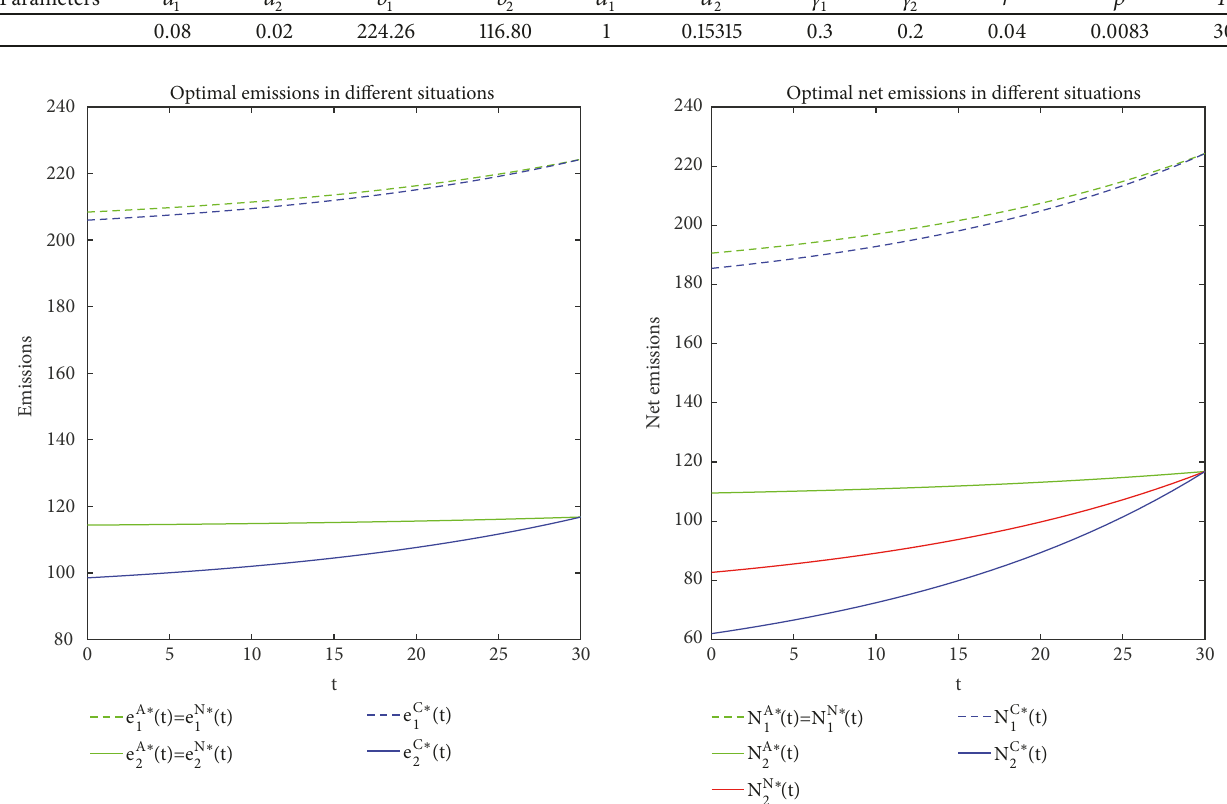
Figure 1: The optimal emissions and net emissions in the case